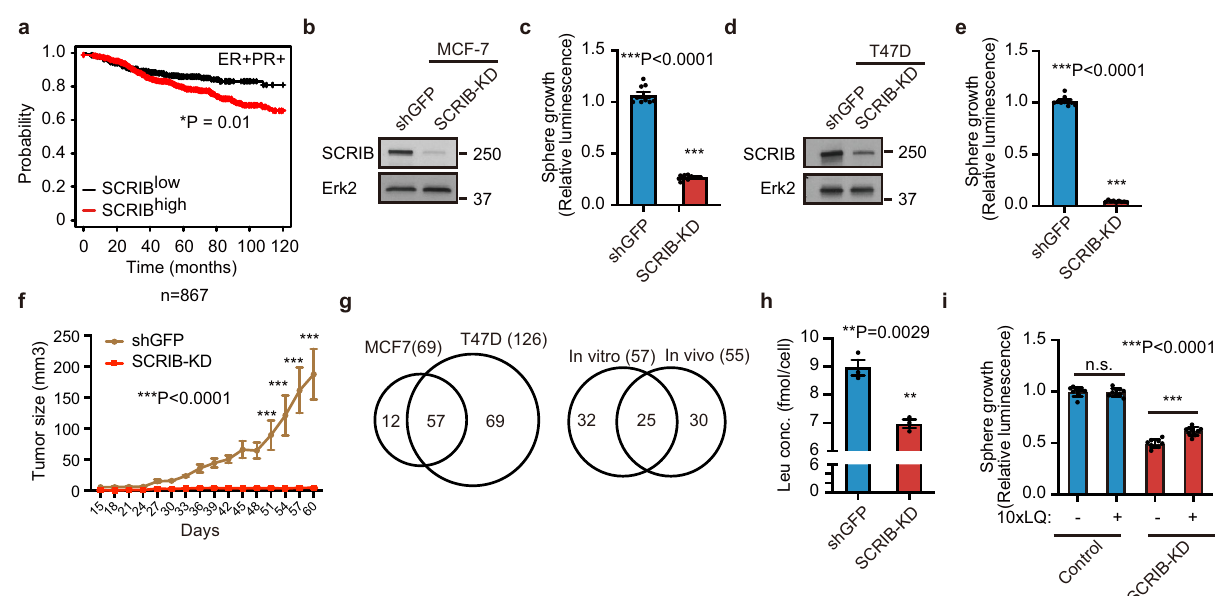
Fig. 1 SCRIB promotes cell proliferation by regulating leucine uptake in ER + breast cancer. a Kaplan – Meier plot of ER + PR + breast cancer patients ’ survival. b Knockdown of SCRIB in MCF-7 cells. c Cell viability assay of SCRIB-KD cells. d Knockdown of SCRIB in T47D cells. e Cell viability assay of SCRIB- KD T47D cells. f Tumor growth of SCRIB-KD MCF-7 cells in NSG mice. g Venn diagram representation of the number of intracellular metabolites downregulated by SCRIB-KD between MCF-7 and T47D cells (left) and between SCRIB-KD cultured cells (in vitro) and SCRIB-KD tumors (in vivo) (right). h Relative concentration of intracellular leucine in MCF-7 cells. i Sphere growth of SCRIB-KD MCF-7 cells in 10X leucine/glutamine (LQ) medium. Data c , e , f , h , and i are shown as mean ± s.e.m.; c , e , and i ; n = 9, h ; n = 3, f ; n = 5. Statistical analysis was conducted by t -test ( c , e , h ), one-way ANOVA followed by Tukey ’ s posttest ( i ), and two-way ANOVA followed by Sidak ’ s posttest ( f